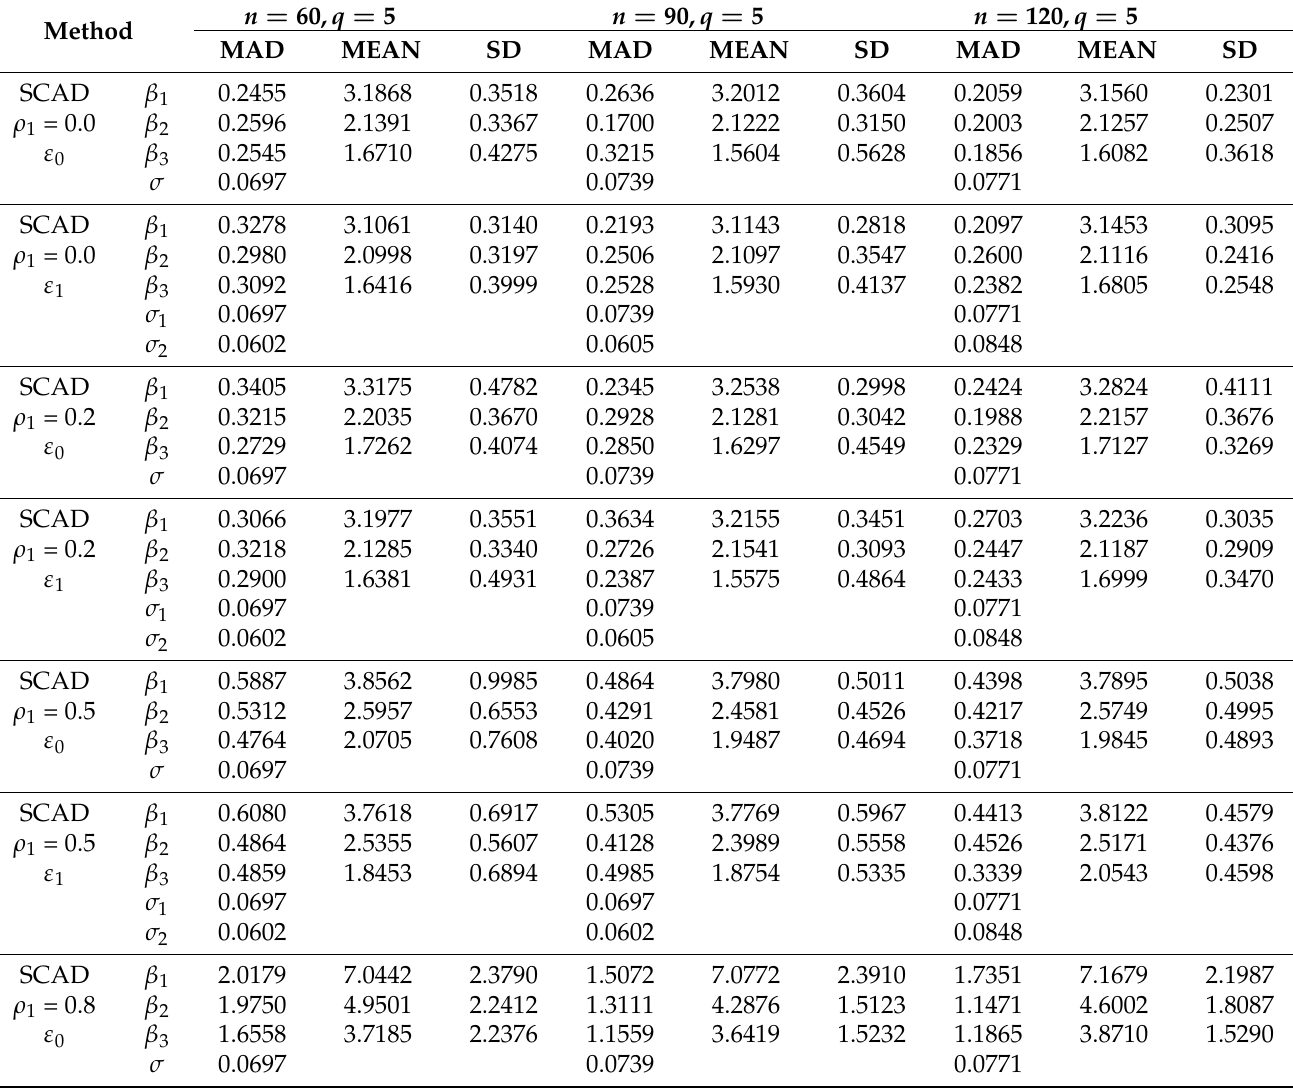
Table 6. Standard deviations and means of estimators of the nonzero regression